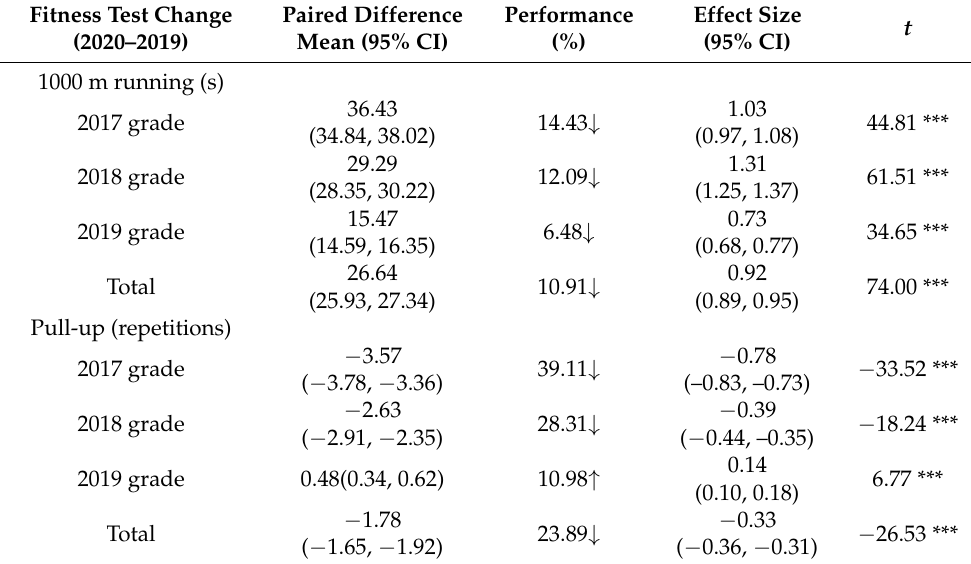
Table 3. Paired t -test results of physical fitness testing in the 2019 year and the 2020